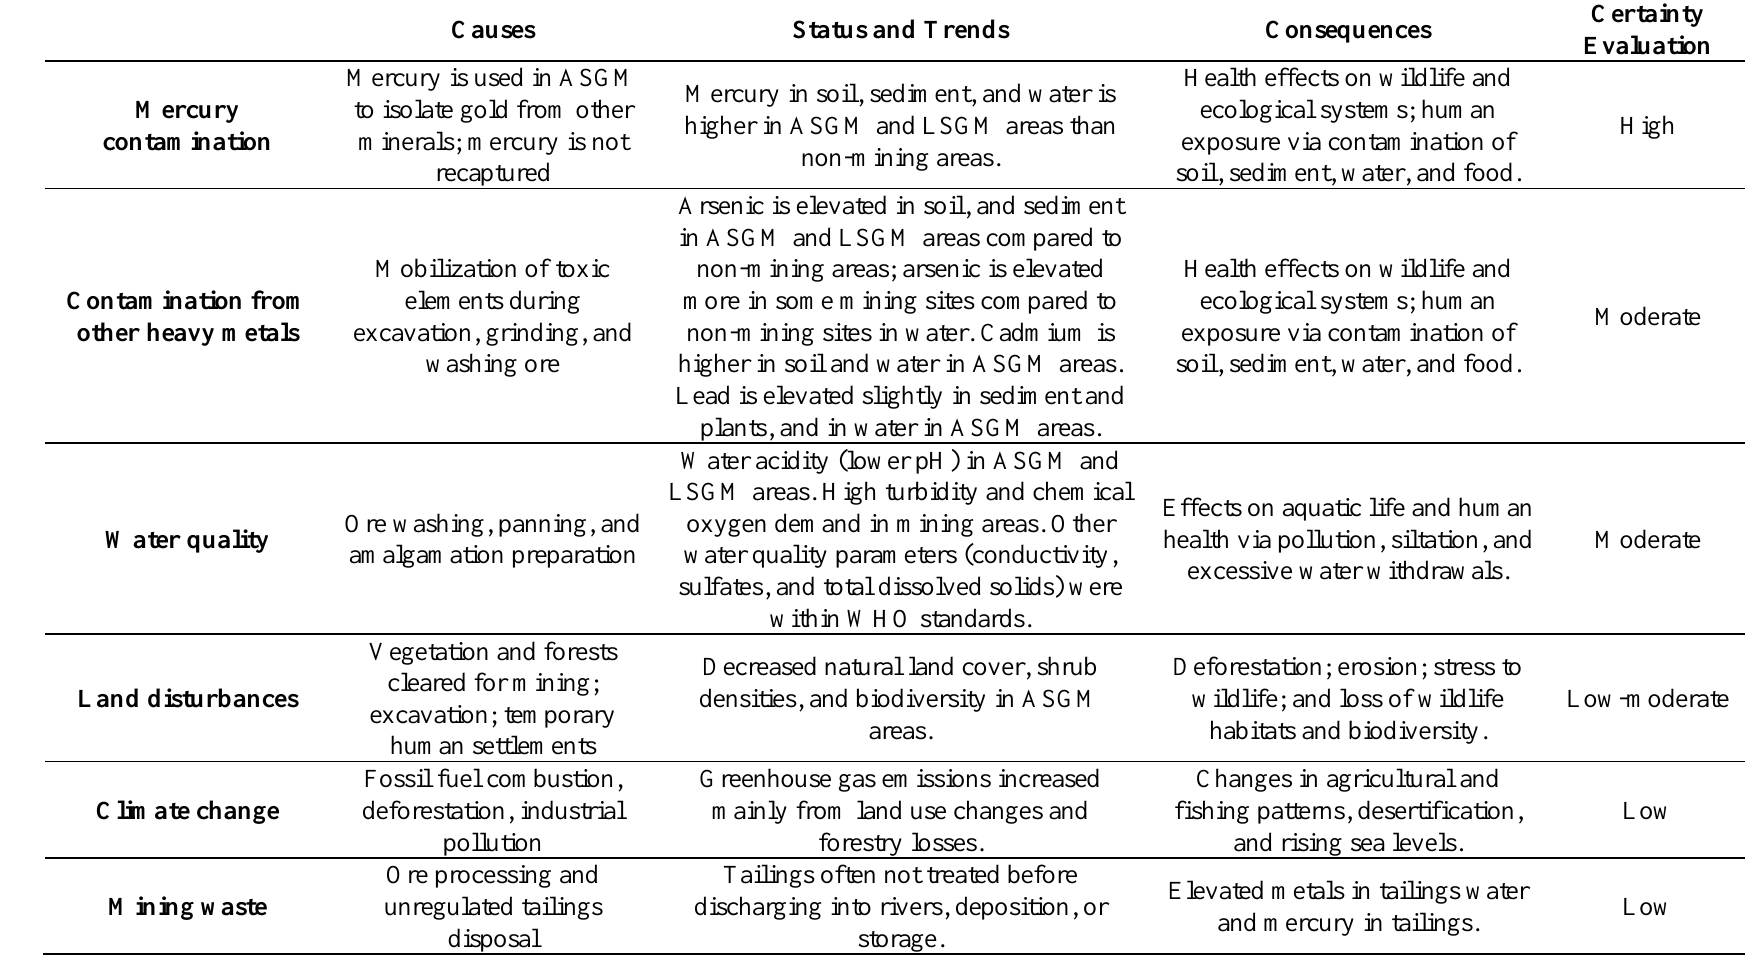
Table 3. Summary of ecological causes, status and trends, consequences, and certainty of ASGM impacts in